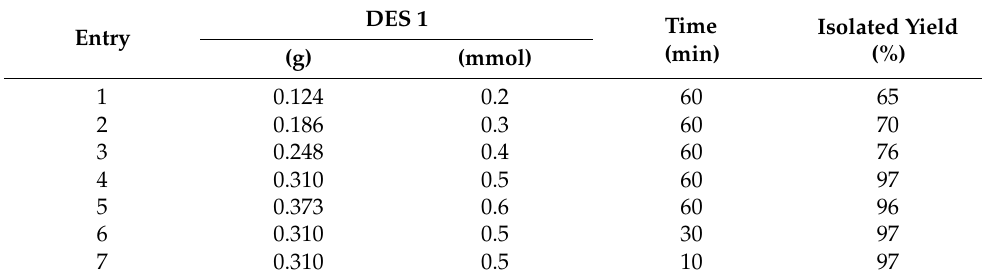
Table 3. Optimization of the reaction conditions.